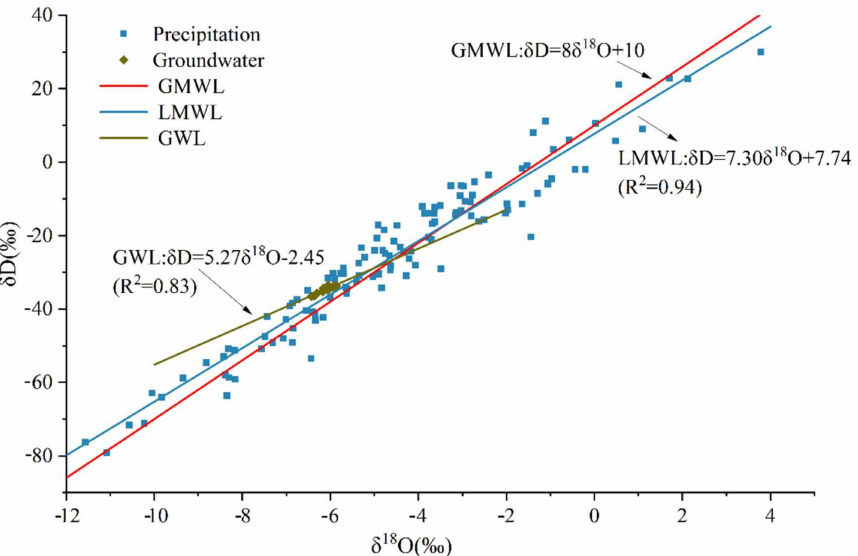
Figure 3. Plots of δ D and δ 18 O in precipitation and groundwater. GMWL is the global meteoric water line ( δ D = 8 δ 18 O + 10) [34,41], LMWL represents the local meteoric water line, and GWL represents